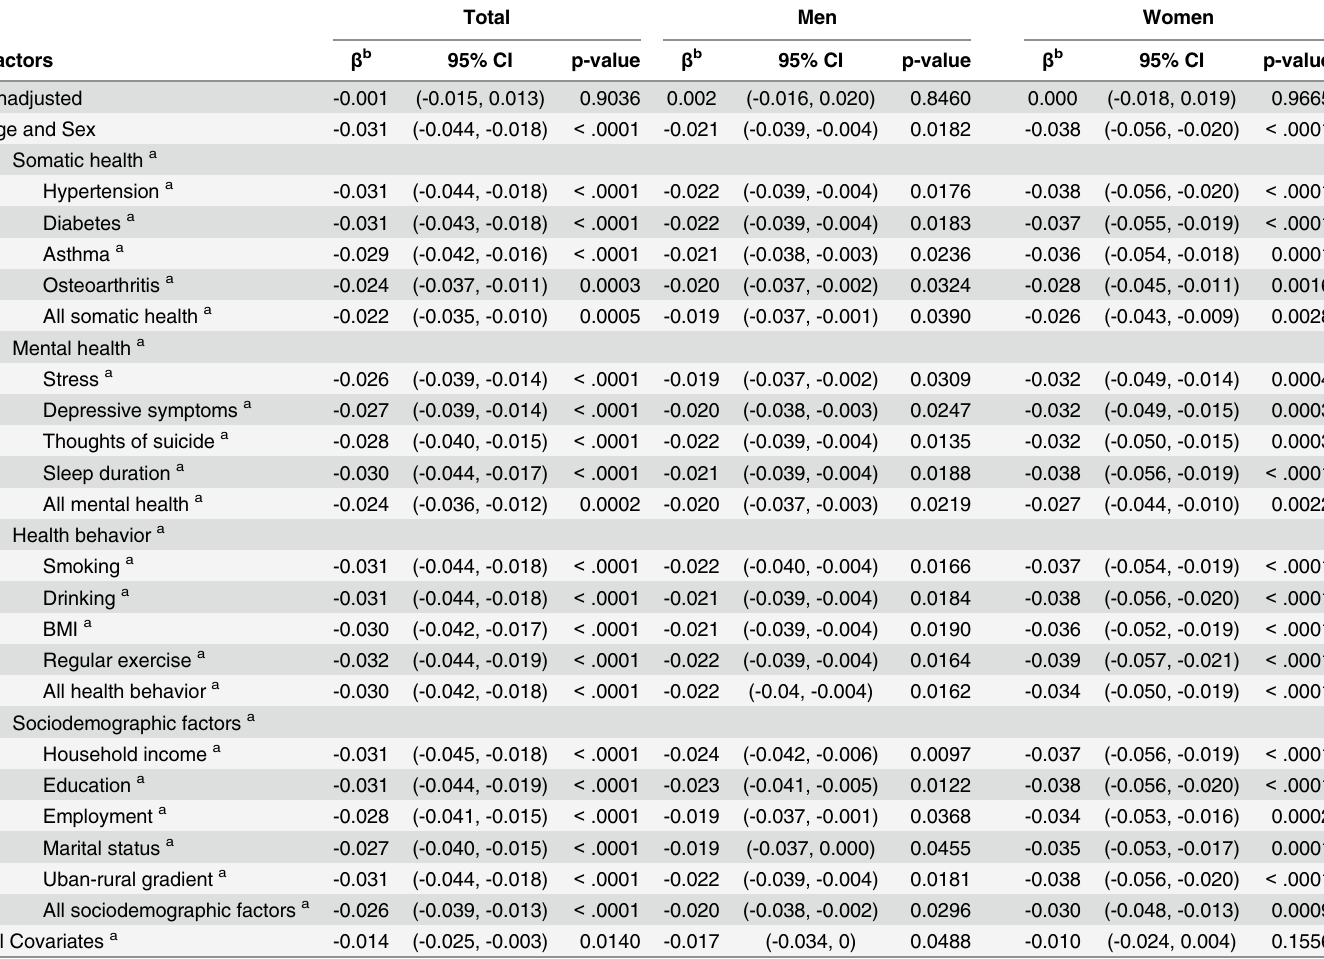
Table 3. Influence of covariates in linear regression analyses of the association between TMD and quality of life in participants aged (cid:1) 19 years of KNHANES Ⅳ , 2007 to 2009. Total Men